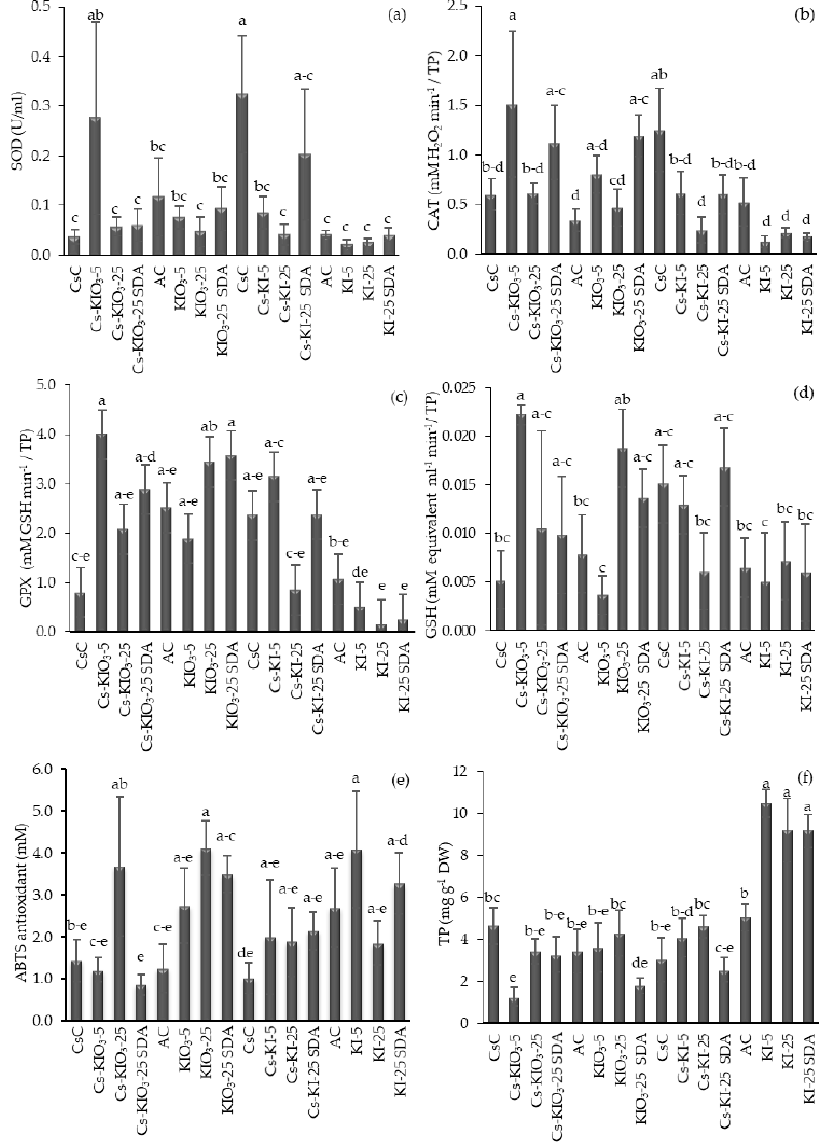
Figure 3. Changes in enzymatic, antioxidant, and protein content of lettuce after treatment with iodine and chitosan. ( a ) Superoxide dismutase, SOD; ( b ) catalase, CAT; ( c ) glutathione peroxidase, GPX; ( d ) reduced glutathione, GSH; ( e ) total antioxidant content; ( f ) total protein, TP. Means with the same letter are statistically identical (LSD, p ≤ 0.05); sample size, 6 (n = 6); the bars represent the standard error. Sample size was 6 (n = 6) for all measurements except SOD (n = 5).